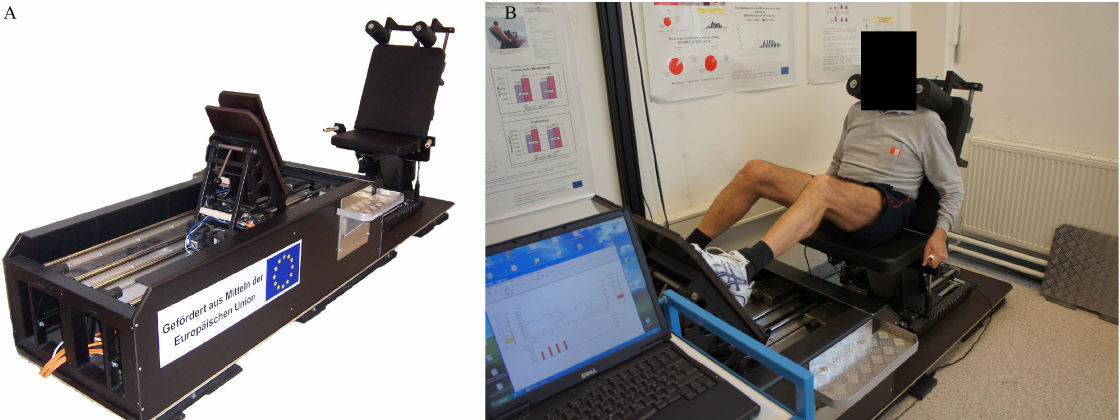
Figure 1. Represents unique linear motor-driven leg press dynamometer ( A ) and position during testing/training ( B